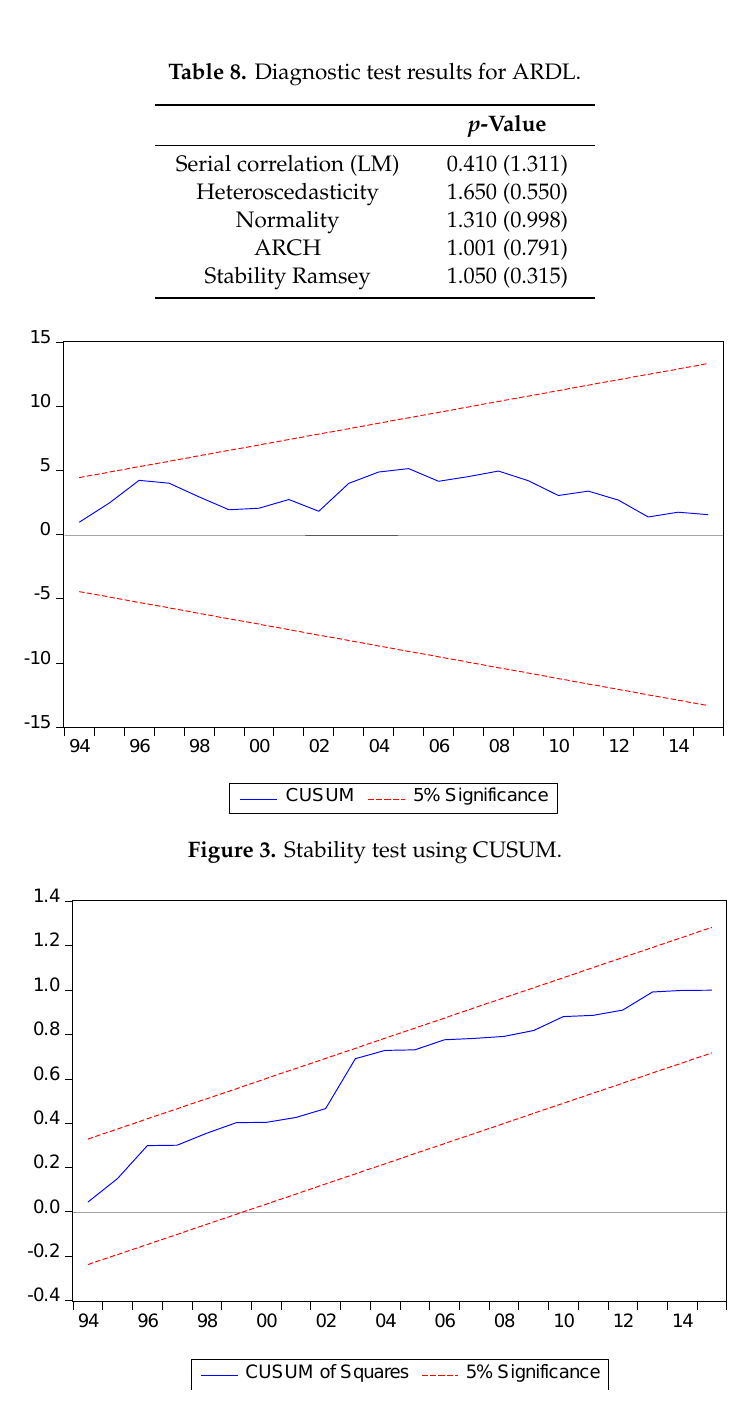
Figure 4. Stability test using CUSUMQ.